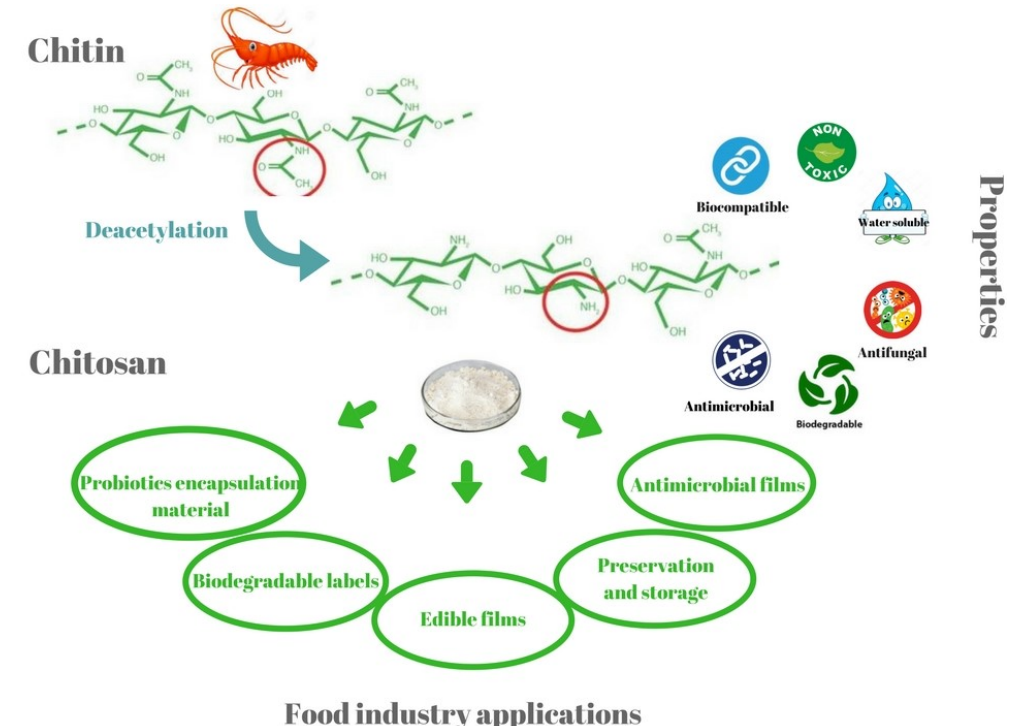
Figure 6. Some of the unique properties and food industry applications of chitosan (taken [15] under Creative Commons License).